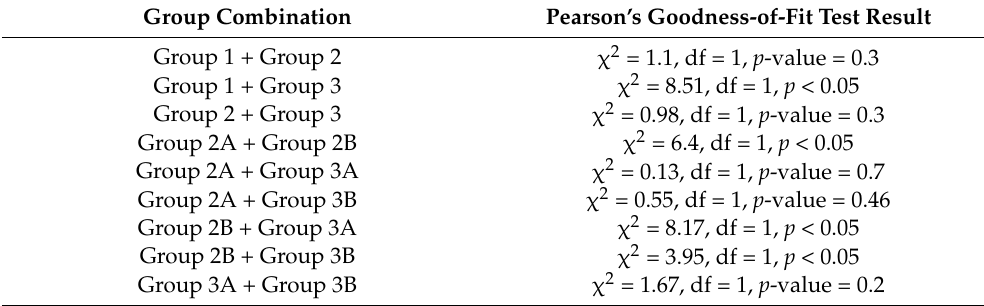
Table 2. Sex distribution in the studied